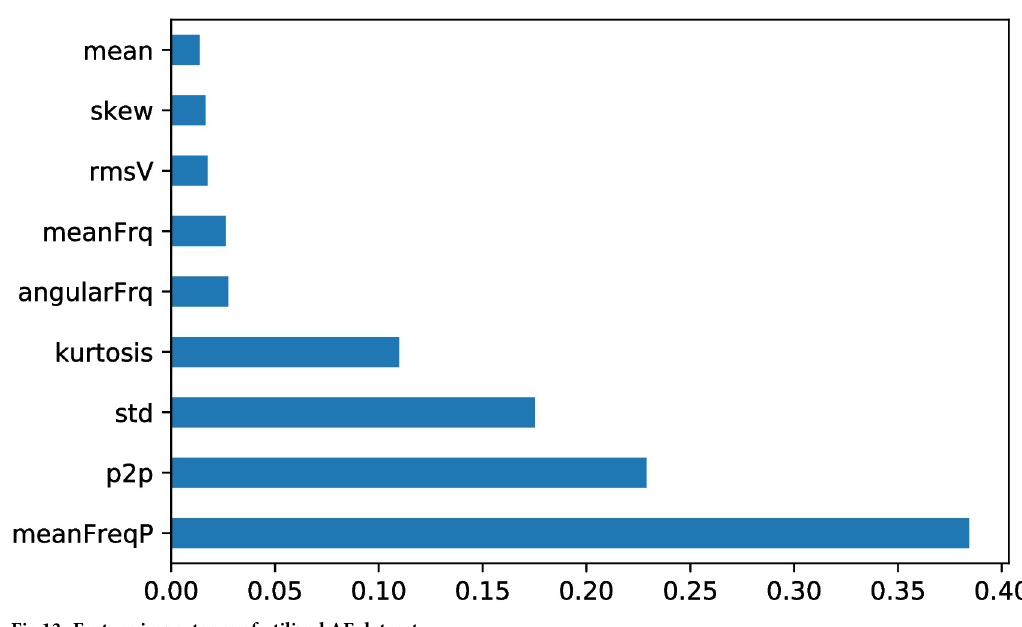
Fig 13. Feature importance of utilized AE dataset.